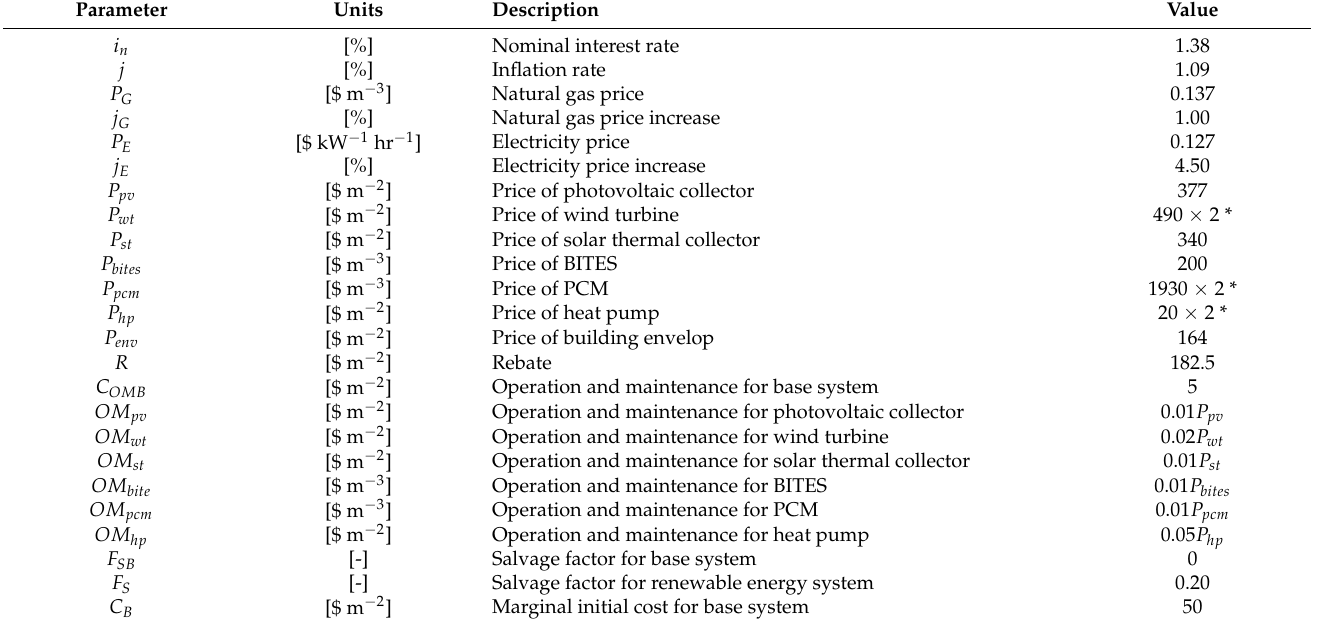
Table 4. Parameters required for the economic analysis; *: Systems that require one replacement over the investment horizon. Parameter Units i